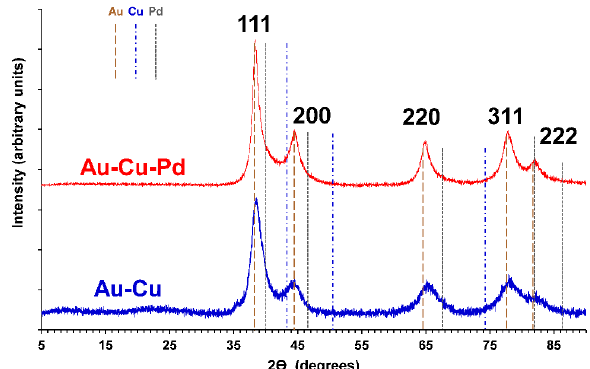
Figure 4. X-ray diffraction spectra of Au-Cu nanofoams and Au-Cu-Pd macrobeams. Peaks were indexed to JCPDS reference number 01-071-4615 for Au (brown dashed lines), 03-065-9743 for Cu (blue dashed lines), and 01-088-2335 for Pd (gray dashed lines). Dashed line heights are equal for each Miller index.